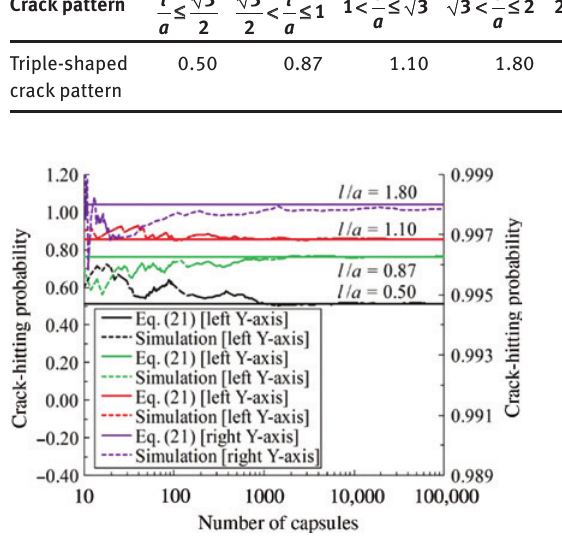
Figure 13: The minimum required number of capsules per unit area N for different 2D crack A